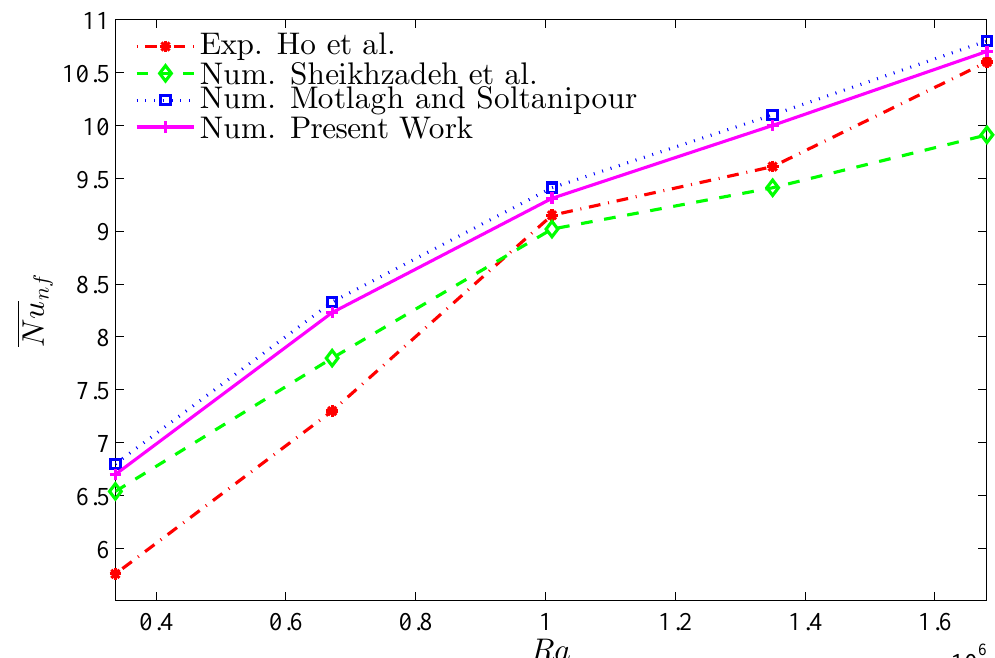
Figure 3. Comparison of the mean Nusselt number obtained from present numerical simulation with the experimental results of Ho et al. [36], numerical results of Sheikhzadeh et al. [37] and numerical results of Motlagh and Soltanipour [19] for different values of Rayleigh numbers.